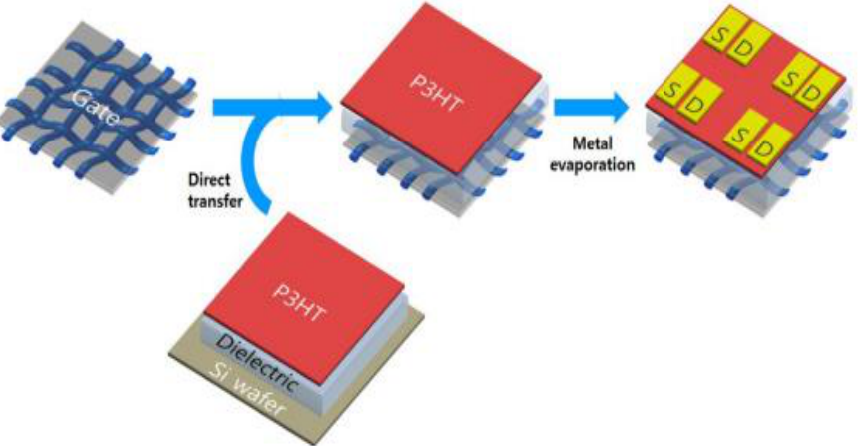
Figure 13. Representation of the fabrication process of the FET based on graphene/silver nanoparticle (AgNP) textile. P3HT: Poly(3-hexylthiophene); S: Source electrode; D: Drain electrode. Reproduced from ref. [63], copyright 2016, MDPI.